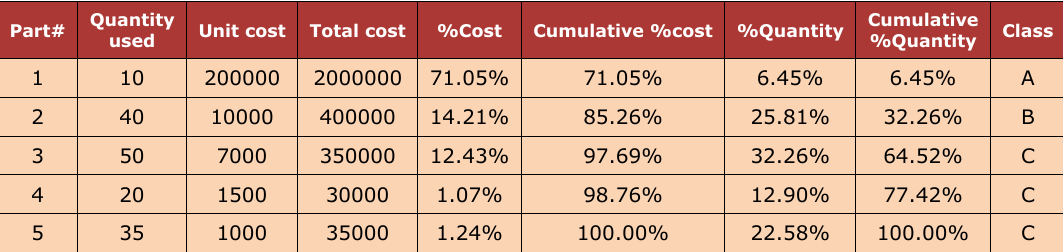
Table 1. Example of ABC